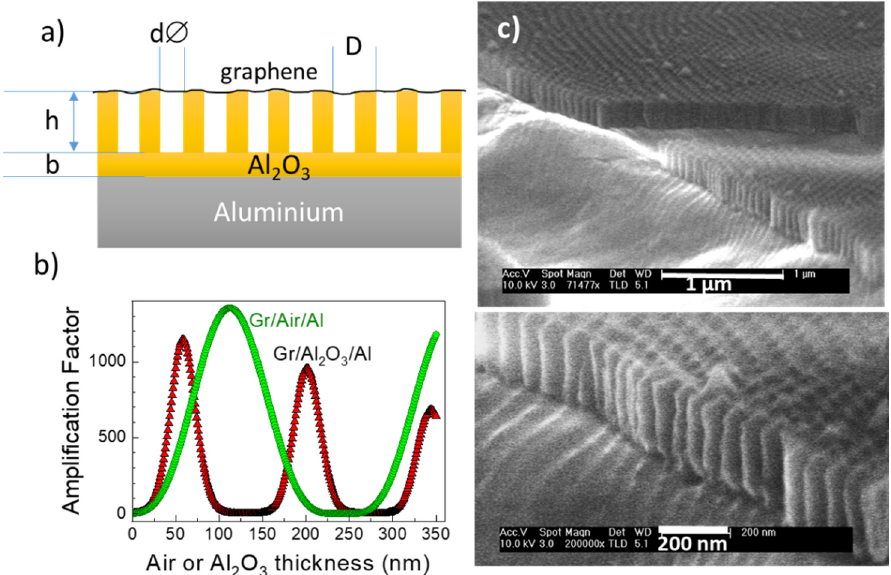
Figure 1. ( a ) Schema of the section of a supported membrane with a single layer graphene transferred on top of it, ( b ) calculated Raman amplification with Al 2 O 3 (red triangles) or air (green circles) as the dielectric layer for 488 nm laser excitation, ( c ) scanning electron microscopy (SEM) images of an alumina supported membrane with h ≈ 200 nm.